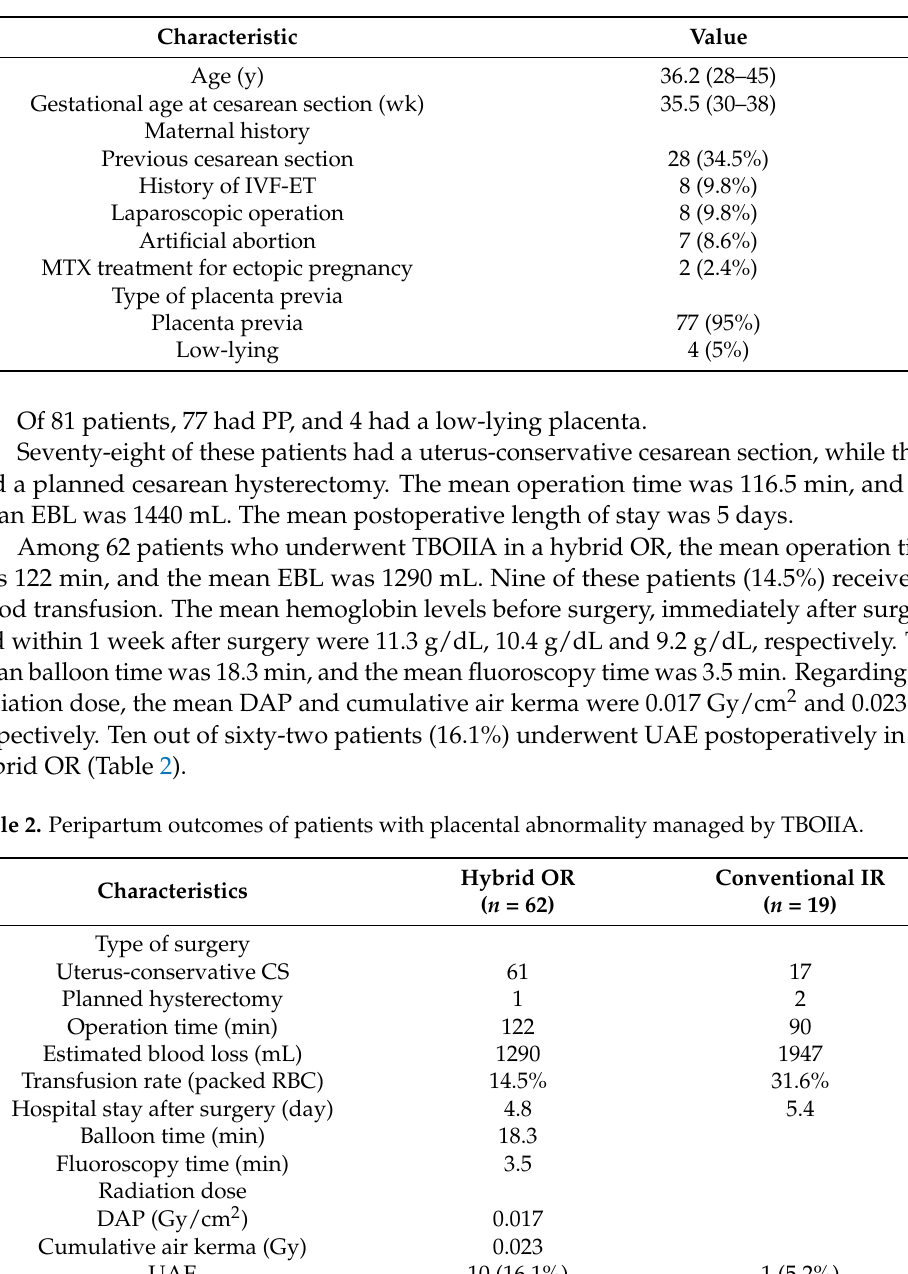
Table 1. Demographics and obstetric characteristics of 81 patients who underwent TBOIIA prior to cesarean section. Values are expressed as number (range) or number (percentage). TBOIIA, temporary transcatheter balloon occlusion of bilateral internal iliac arteries; IVF-ET, in vitro fertilization and embryo transfer; MTX, methotrexate.